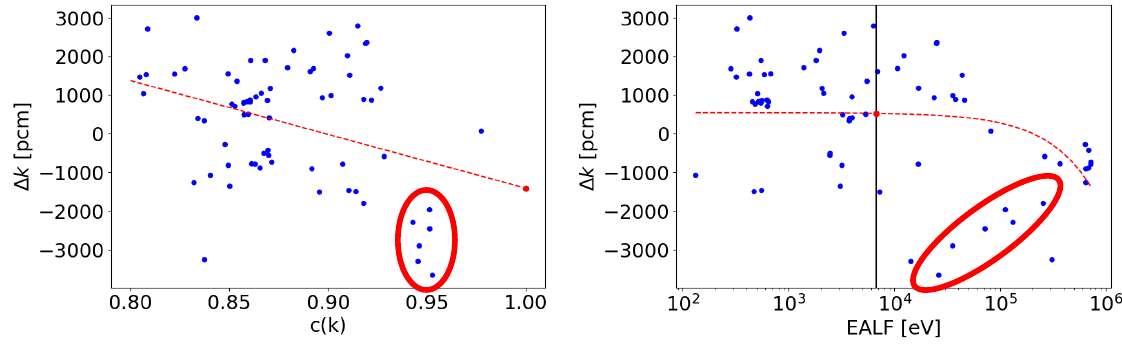
Figure 1b and 1c. The error between the model (left) and the corresponding experiment (right) as a function of c